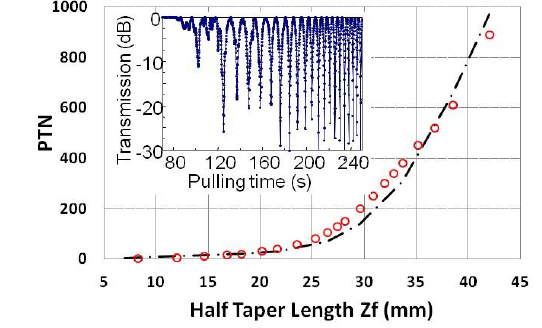
Fig.3. Power transfer number PTN versus ½ taper length for different taper elongations . Broken line, mode coupling theory fitting . Inset - transmitted power at 1575 nm as a function of the first 240 seconds of the heat-and-pull process.